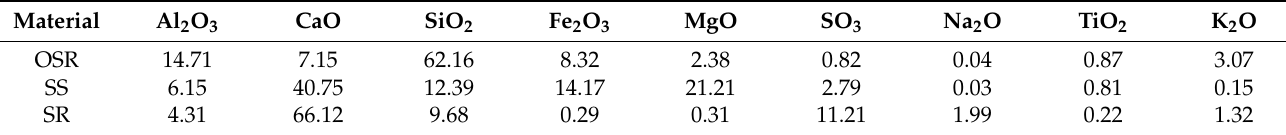
Table 1. Main chemical compositions of the raw materials (wt%).